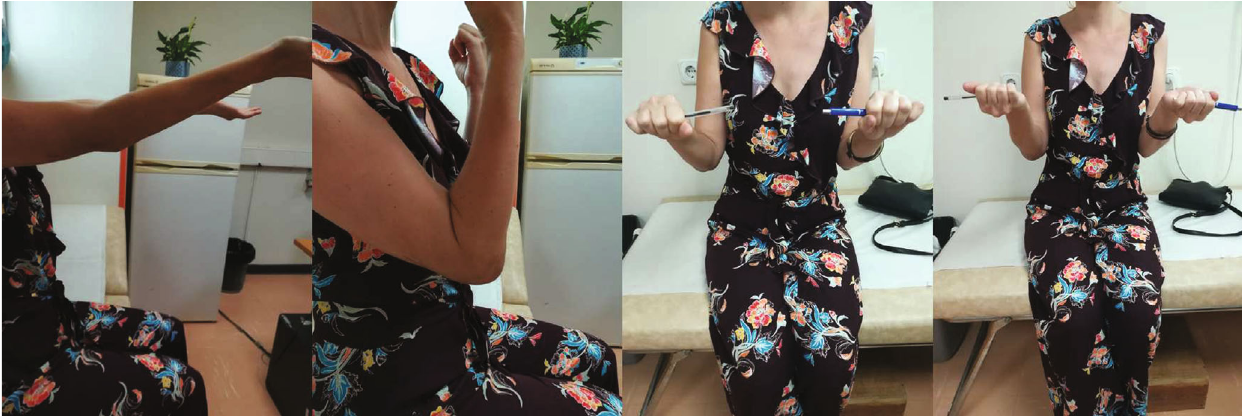
Figure 3: Right elbow ROM six months postoperation.